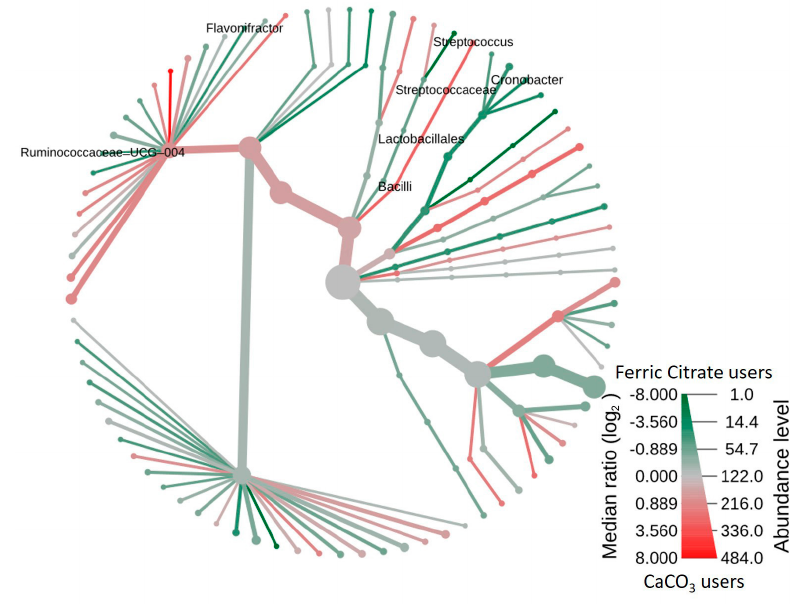
Figure 3. Heat tree depicting the effects of phosphate binder treatment on the intestinal microbiomes of hemodialysis patients. In comparison between ferric citrate and calcium carbonate phosphate binder, members of the class Bacilli were prominent in calcium-containing phosphate binder, whereas taxa of the genus Ruminococcaceae UCG-004 , Flavonifractor , and Cronobacter were enriched in ferric citrate phosphate binder users. The heat tree was generated using Metacoder.